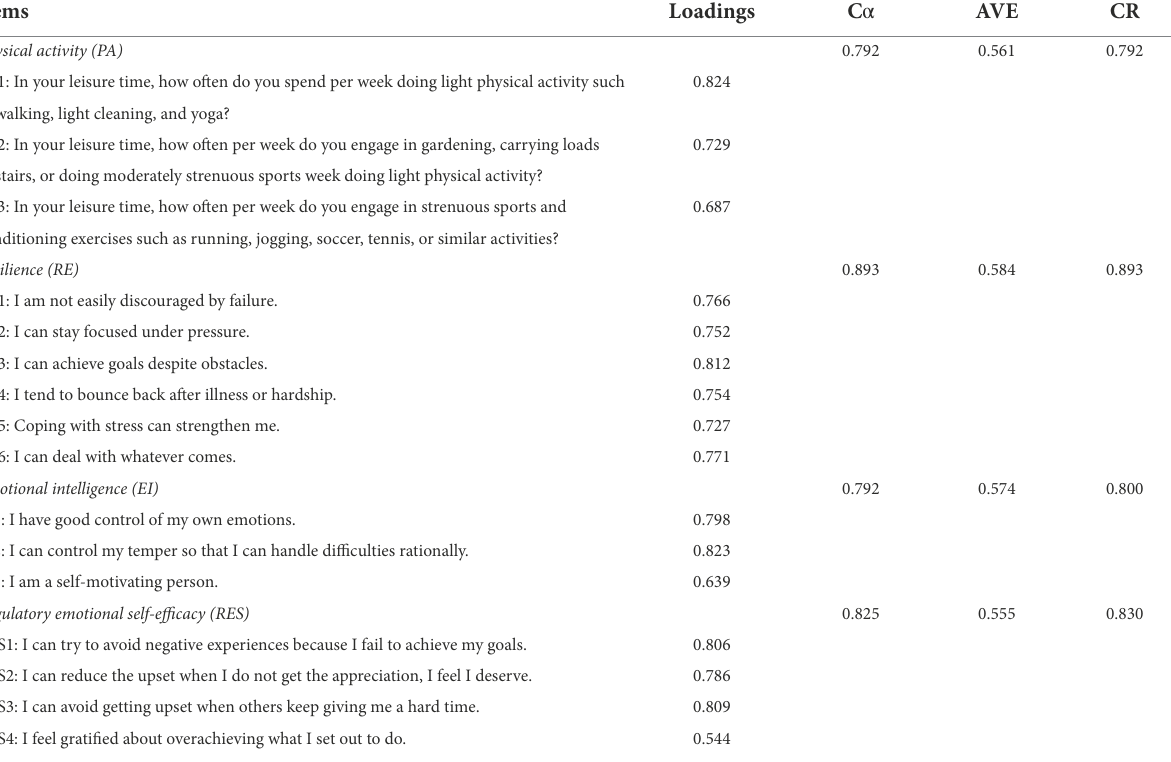
TABLE 1 Reliability and validity